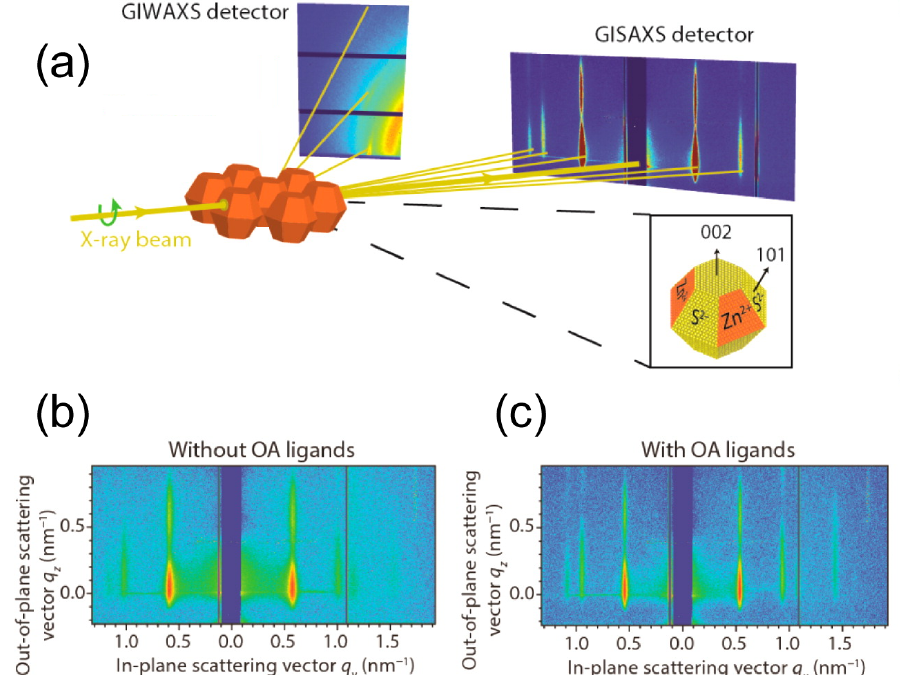
Figure 17. ( a ) Schematic representation of the in situ simultaneous GISAXS and GIWAXS measurements of 2D zinc sulphide (ZnS) nanocrystal superlattice structure developing at a liquid–vapor interface. The inset shows an enlarged wurtzite hexagonal bifrustum-shaped ZnS nanocrystal. Bottom panels show GISAXS patterns during the formation of the 2D hexagonal ZnS superstructure with scattering rods in the in-plane scattering direction ( b ) without and ( c ) with oleic acid (OA) ligands which induce atomic scale alignment of nanocrystals and promote the superlattice formation. Adapted from Van der Stam et al. [148] with permission from the American Chemical Society under ACS Author Choice License.